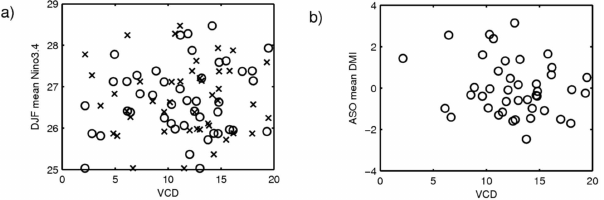
Fig. 6. Scatter plots of: (a) mean Nino3.4 in December-January- February (DJF) versus number of very cold days (VCD) in the same year (crosses) and the next year (circles) by the December month; (b) mean DMI in August-September-October versus VCD in the same